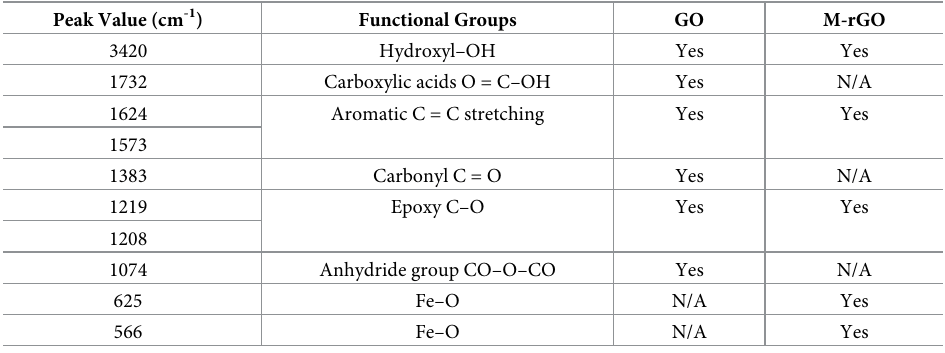
Table 4. FTIR analysis of GO and